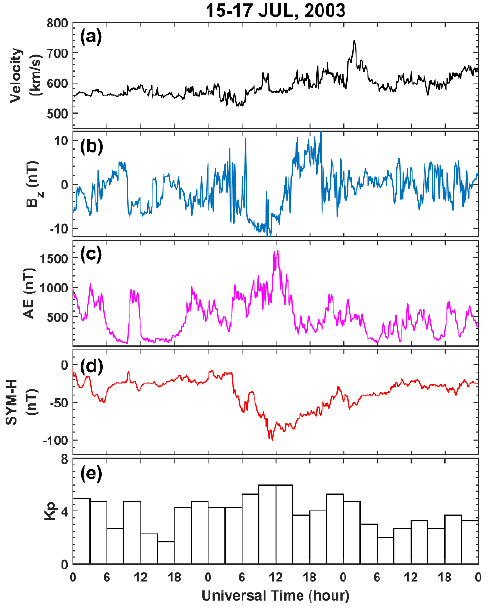
Figure 2. Geophysical conditions during the period 15 – 17 July 2003: ( a ) solar wind velocity, ( b ) IMF Bz, ( c ) AE index, ( d ) SYM-H index, and ( e ) Kp index. IMF = interplanetary magnetic field.